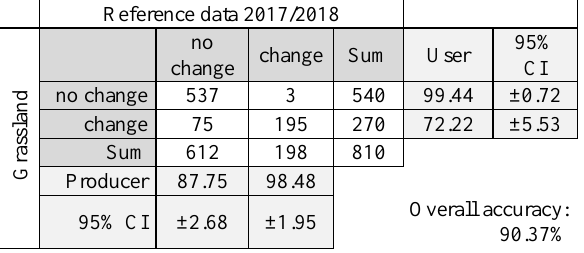
Table 5 . Confusion matrix for change layer Grassland The change layer for the class “Grassland” (see Table 5) is well suited to show changes towards urban areas. In addition, misallocations in the reference (e.g. arable land instead of grassland with trees) can be reliably detected. The majority of commission errors must be attributed to drought-related areas.